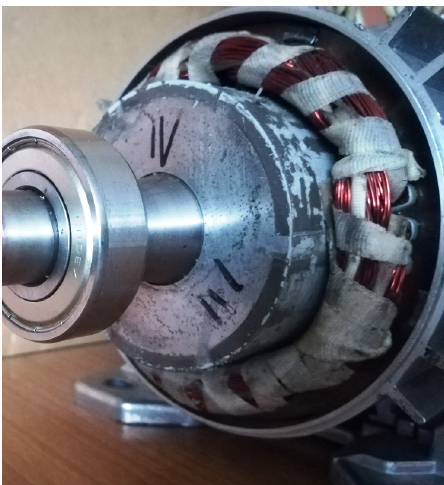
Figure 7. Protruding rotor of the motor, on the circumference of which we can see glued magnets separated by a